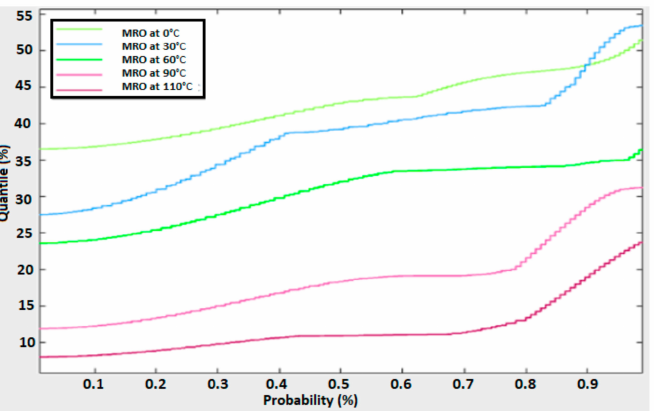
Figure 17. Inverse cumulative probability of MRO showing the probability of data items with different survival rate.